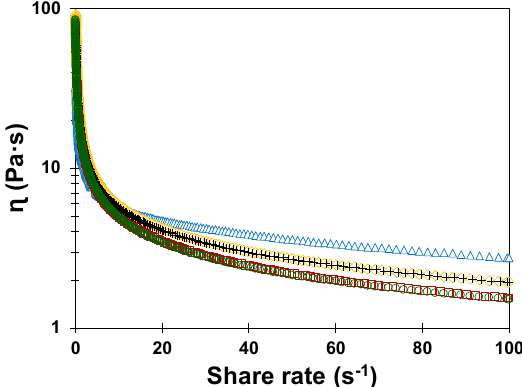
Figure 1. The impact of sucrose replacement by agave syrup (AS) and partially hydrolyzed agave syrup (PHAS) on flow curves of the muffin batters: control (blue triangles), PHAS-50 (black crosses), AS-50 (yellow diamonds), PHAS-100 (green circles), and AS-100 (red squares). Figure 2A,B show the frequency dependence of the different batters on the elastic modulus (G’), the viscous modulus (G ″ ), and the phase angle ( δ ) at 25 °C. At low frequencies (0.1–1 Hz), the control